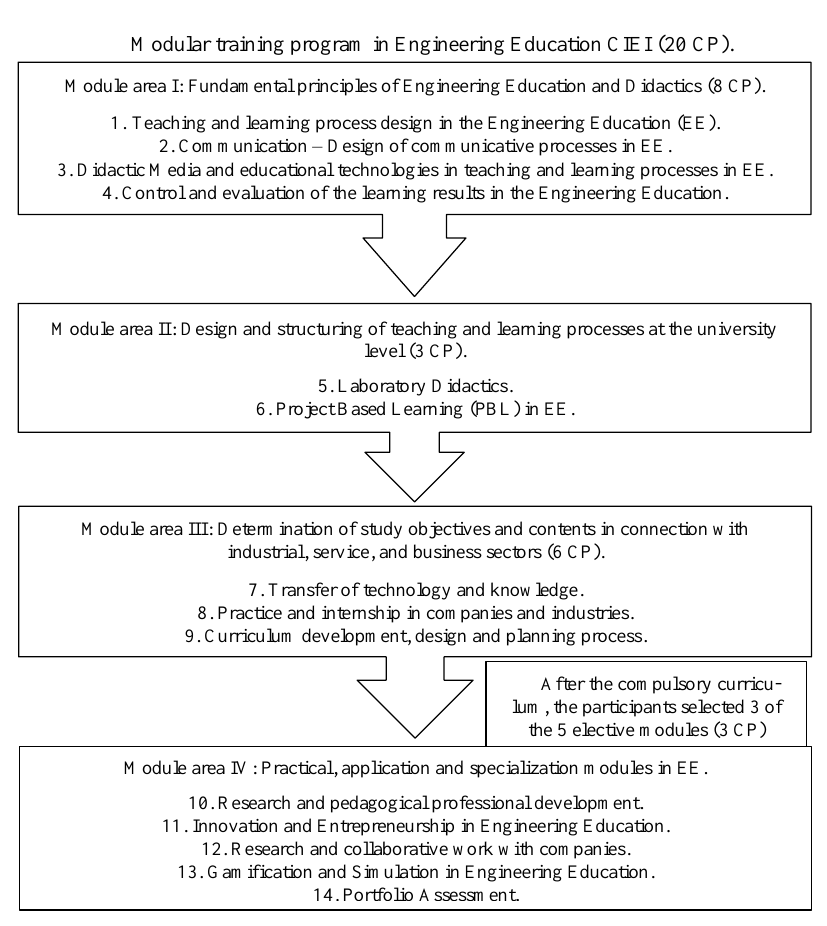
Fig. 2. Modular curricula (Program) for teaching staff in Engineering Education CIEI